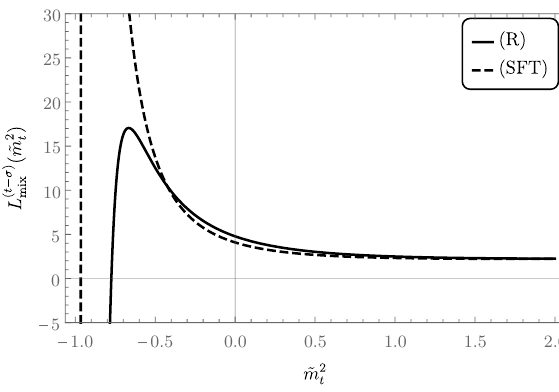
Figure 2 . Behavior of L ( t − σ ) v = 0 . 0129 in (R): (2.42) and v = 0 . 544 (SFT): (2.38) and fix ω = 1 / 2